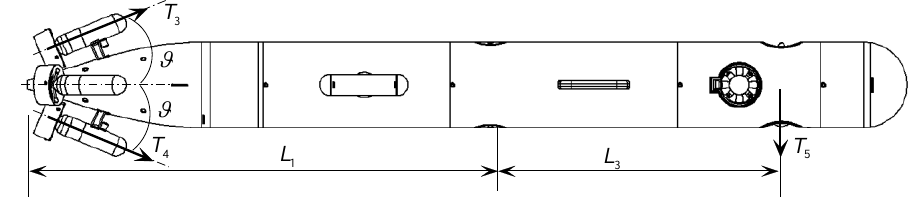
Figure 4. Force analysis in the horizontal plane.